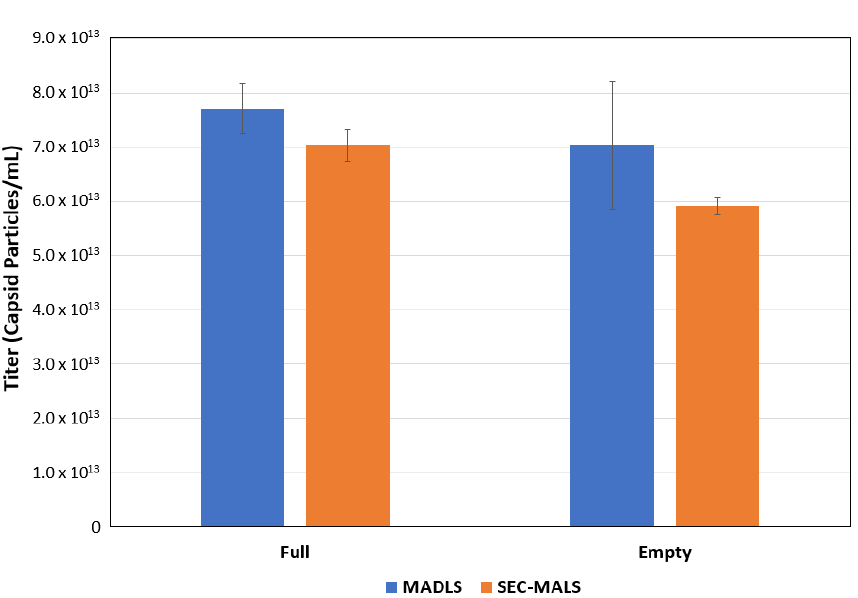
Figure 3. Comparison of full and empty rAAV titer (capsid particles/mL) using SEC–MALS and MADLS.